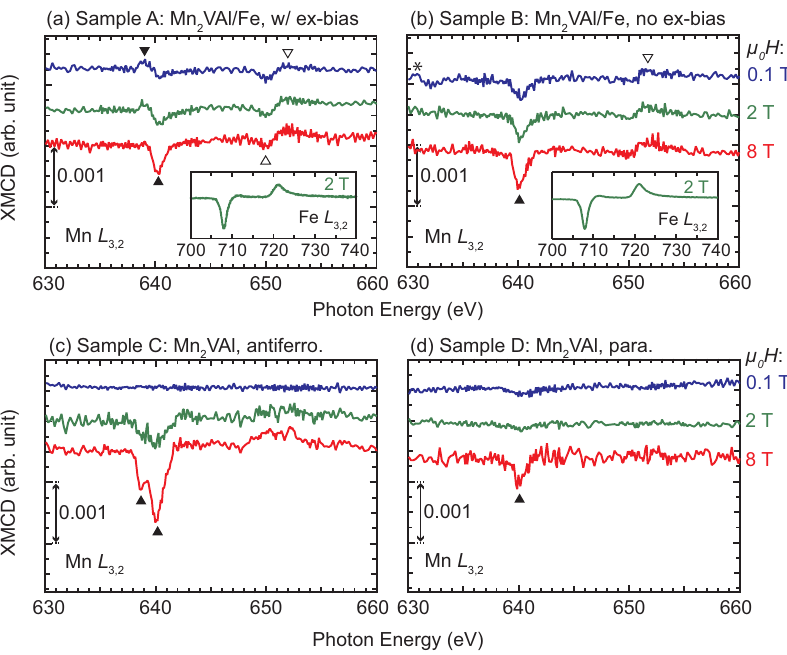
Figure 6. Soft X-ray magnetic circular dichroism (XMCD) spectra around the Mn L 3,2 -absorption edges for the Mn 2 VAl/Fe layered and Mn 2 VAl single layer films measured at different H . ( a ) Sample A, ( b ) Sample B, ( c ) Sample C, and ( d ) Sample D. All spectra were measured at 100 K. Peaks observed around the L 3 ( L 2 )-absorption edge are marked by solid (open) triangles. A peak marked by ∗ is the experimental noise. The insets in panels ( a , b ) are the XMCD spectra around the Fe L 3,2 -absorption edges for samples A and B,